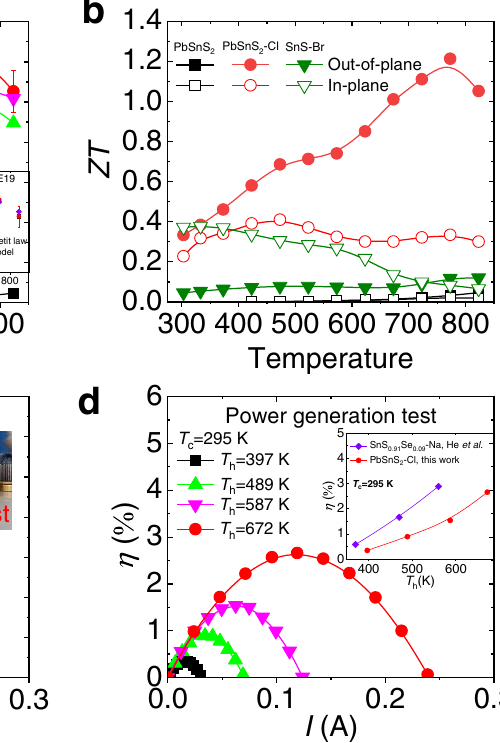
out-of-plane directions. c Output power P , the inset shows the mini-PEM test. d Powergenerationef fi ciency η forsingle-legdevicebasedontheoptimalCldoped PbSnS 2 crystal. Comparison of single-leg power generation ef fi ciency between the optimal Cl doped PbSnS 2 crystal in this work and and p-type SnS crystal 16